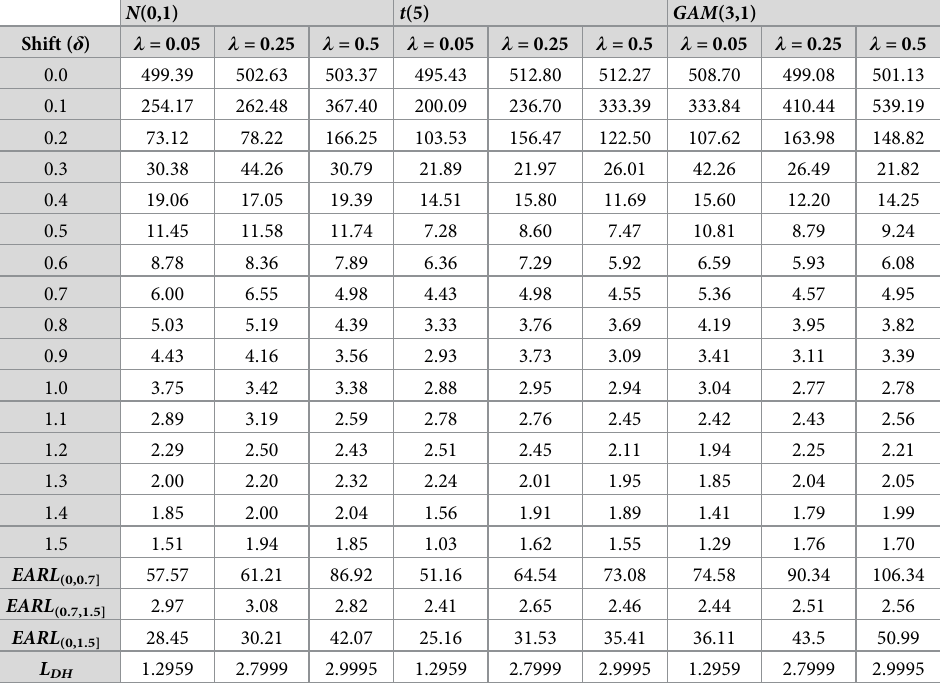
Table 3. The ARL profile of the DHWMA W scheme when ( m , n )= (100,5) and λ 2 {0.05, 0.25, 0.5} for a nominal ARL 0 = 500 under N (0,1), t (5) and GAM (3,1)